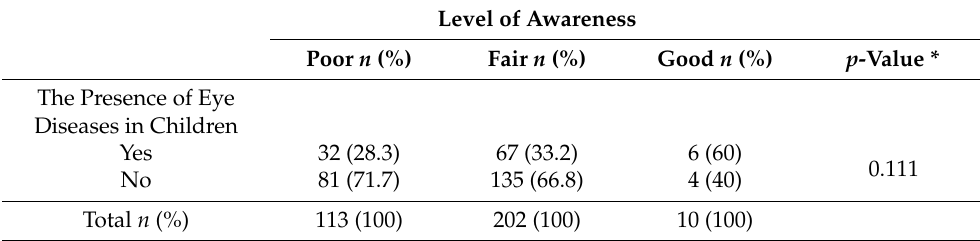
The Presence of